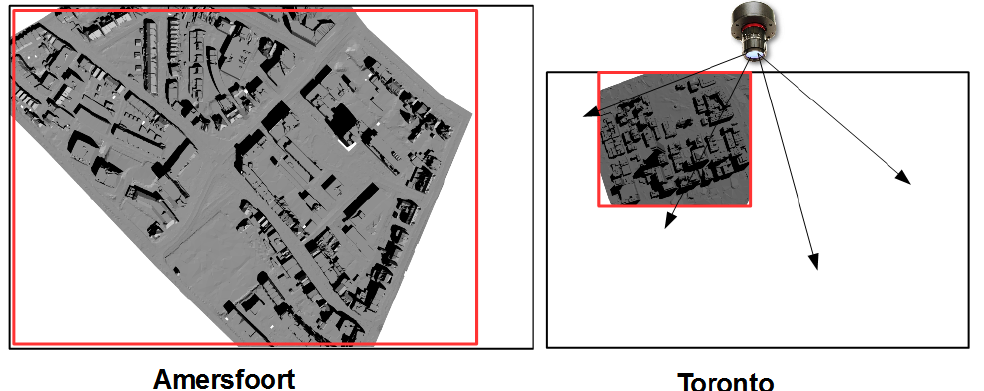
Figure 6. Shadow images from reconstruction by ray tracing for Amersfoort and Toronto 3D models. The pixels with rays which do not intersect with red boxes are filled in the white color with fast computations. Toronto dataset has much more rays which do not hit the model.